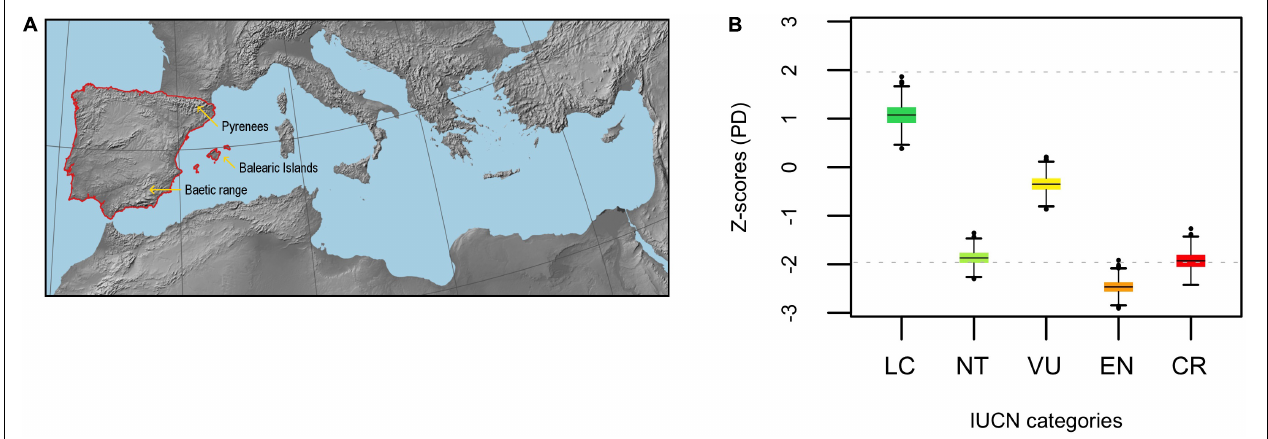
FIGURE 1 | (A) Map of the Mediterranean Basin showing the location of the Iberian Peninsula (region delimited by the red line). (B) Standardized phylogenetic diversity (PD) of extinct risk across IUCN categories (LC, NT, VU, EN, and CR) for the endemic angiosperm flora of the Iberian Peninsula (Z-scores). The horizontal black lines within the boxes represent the mean value of the distribution of Z-scores ( n = 1000 phylogenies) in each case, and the horizontal gray dashed lines are visual references at y = ± 1.96 (significance thresholds for a 5% nominal